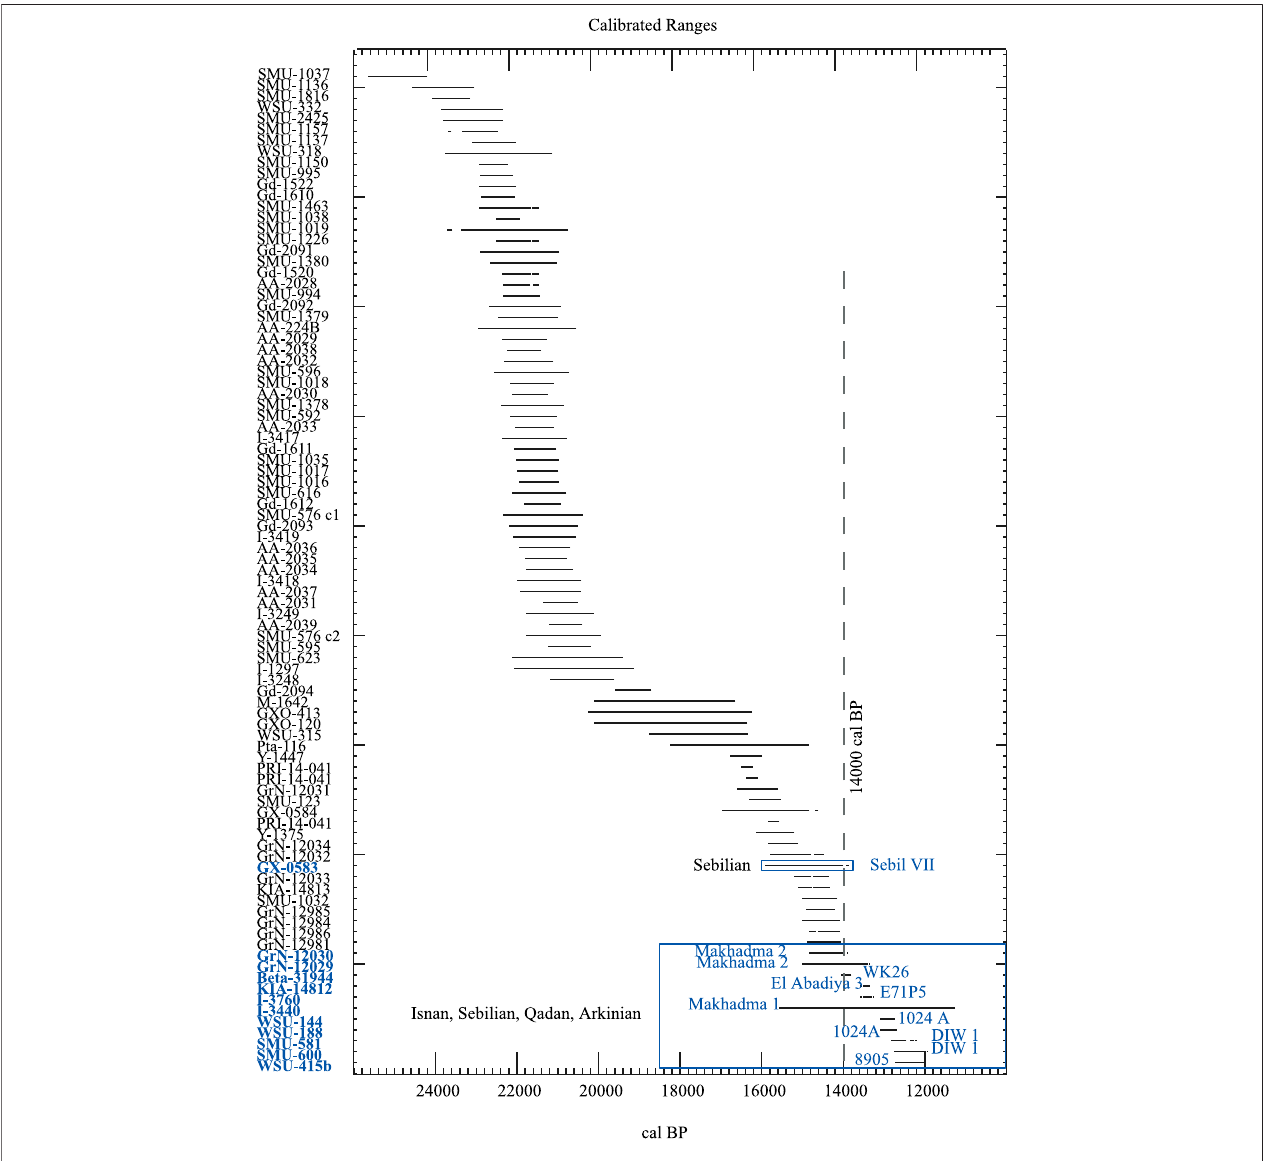
FIGURE5| Barplotsofalltwo-sigmacalibratedrangesofradiocarbondatesconsideredinthepaper(N (cid:1) 91).CreatedusingIntcal20(Reimeretal.,2020)andCalib 8.1 (Stuiver and Reimer, 1993).